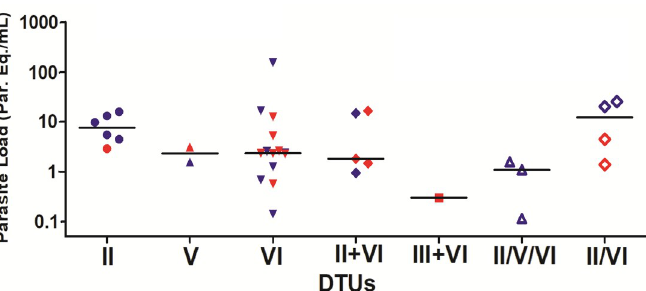
Fig 7. Comparison between T . cruzi genotype, clinical form and parasite load. The symbols represent the parasite load for each patient, distributed by T . cruzi DTUs. The horizontal lines correspond to the median values of parasite load in each DTU. Red symbols indicate patients with CCC and blue symbols indicate patients with the indeterminate form.